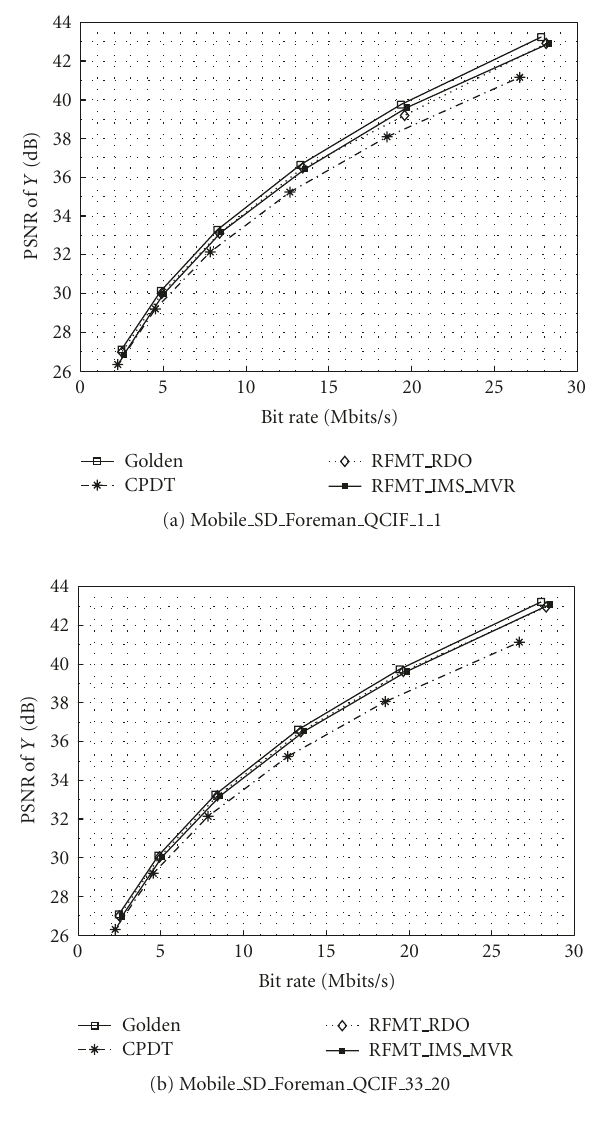
Figure 14: Rate-distortion performance of the luminance compo- nent by four foregrounds